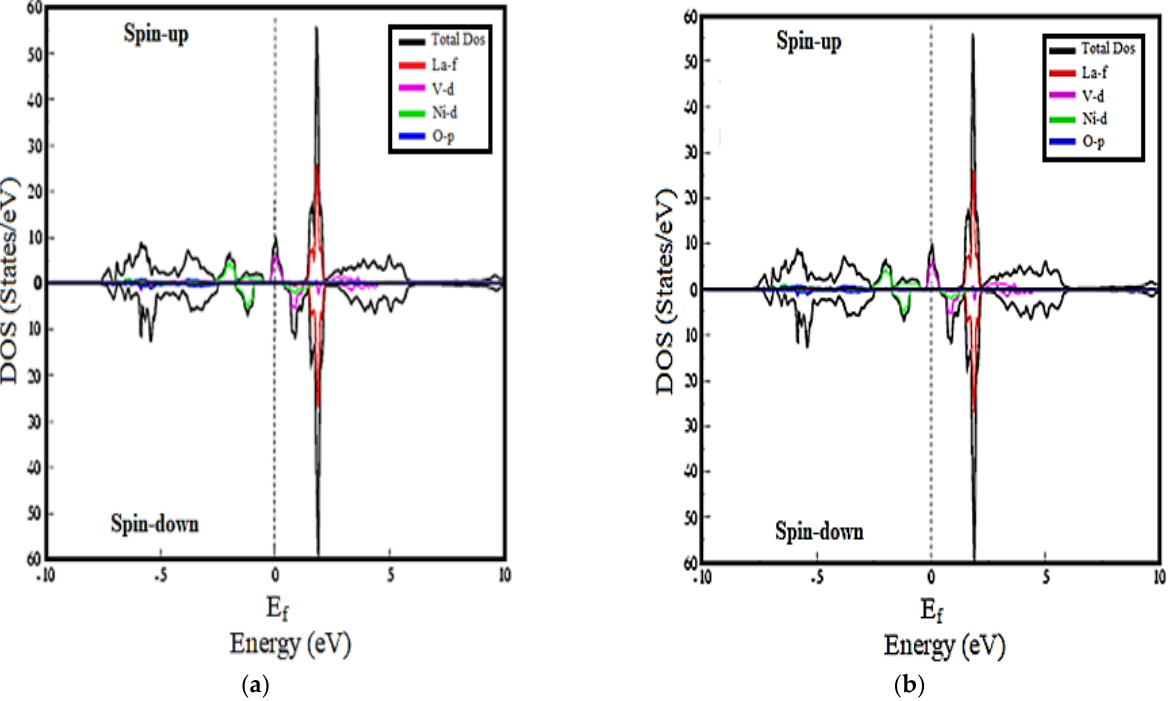
Figure 7. Density of states (DOS) of La 2 VNiO 6 using ( a ) GGA and ( b ) GGA+U.